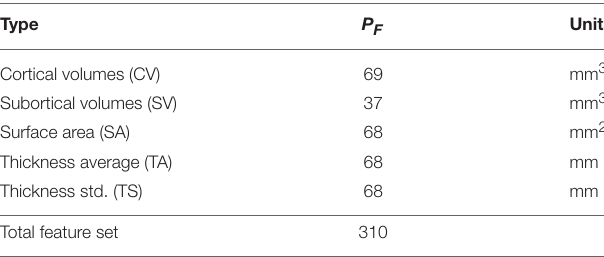
TABLE 2 | Morphological features extracted by FreeSurfer